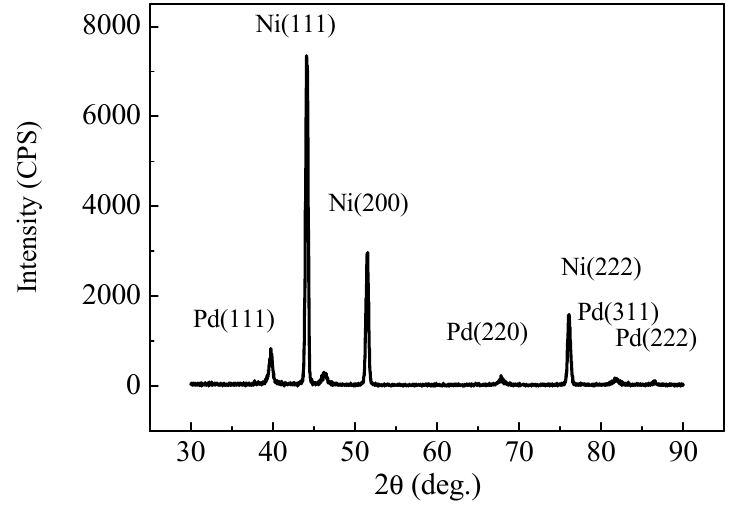
Figure 3. XRD patterns of Pd/foam-Ni electrode.